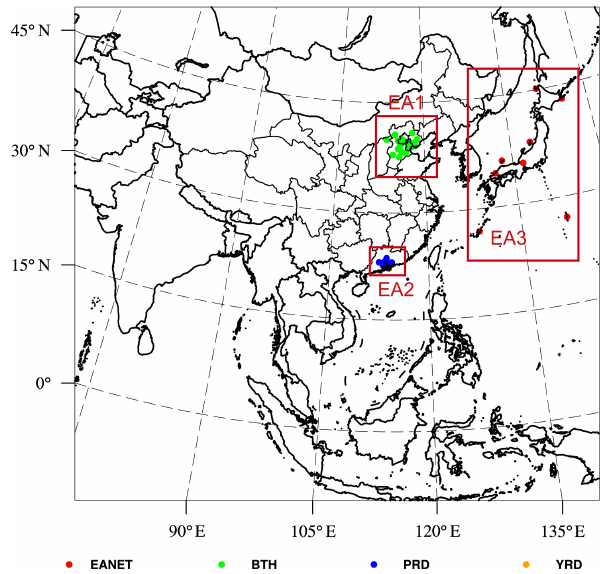
Figure 1. Model domain of models (except M13 and M14) showing the locations of three subregions marked in this study. Also shown are the locations of surface monitoring stations used in this study. The meteorological model used to provide meteorological fields for most models also uses this domain. Note that the domains of M13 and M14 are shown in Fig.